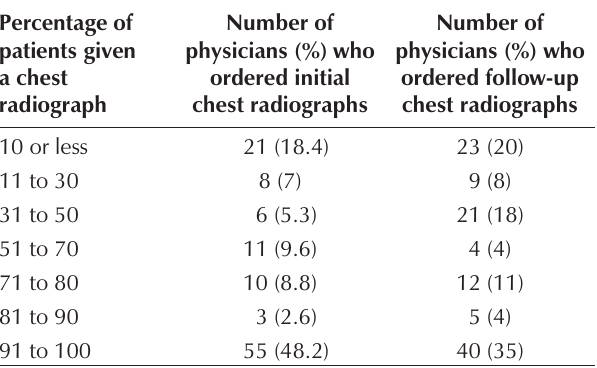
Number of 114 physicians who ordered initial and follow-up chest radiographs on out-patients with a clinical diagnosis of